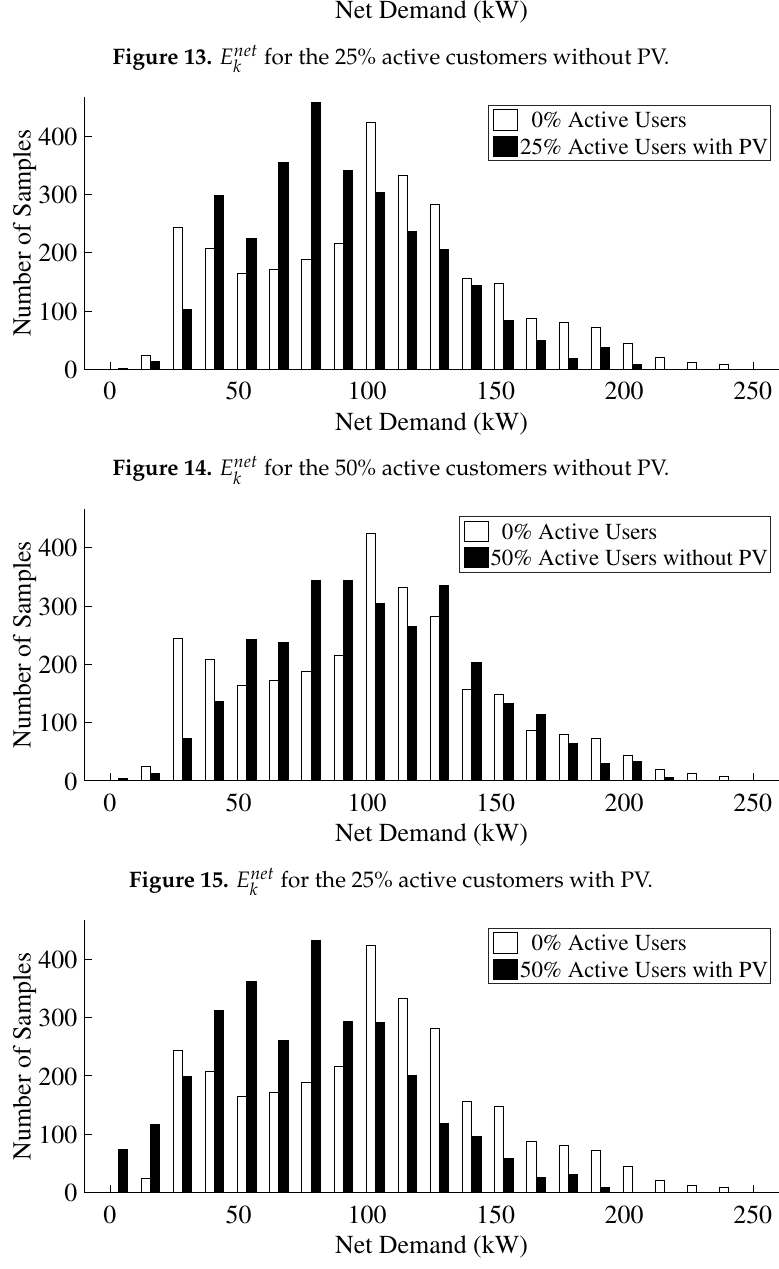
Figure 16. E net for the 50% active customers with k